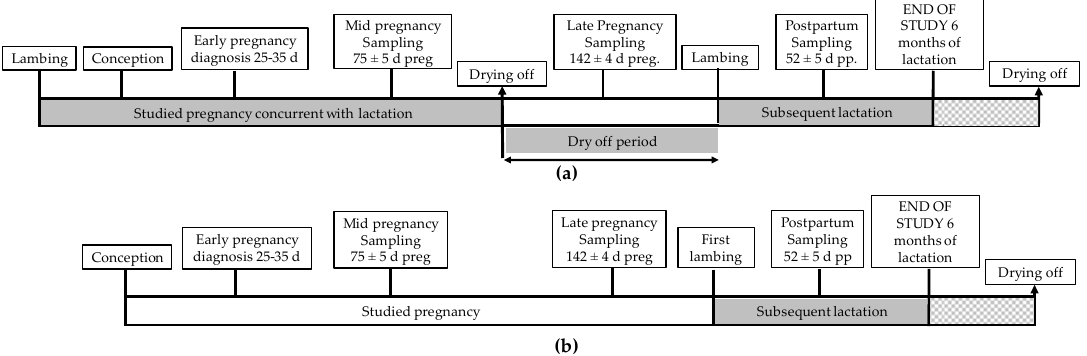
Figure 2. Timeline of monitoring of ( a ) pregnant adult sheep and ( b ) pregnant maiden sheep. Measurements were taken three times (in mid-pregnancy, in late pregnancy, and postpartum) distributed over the “studied” lactation and pregnancy as well as the “subsequent” lactation.